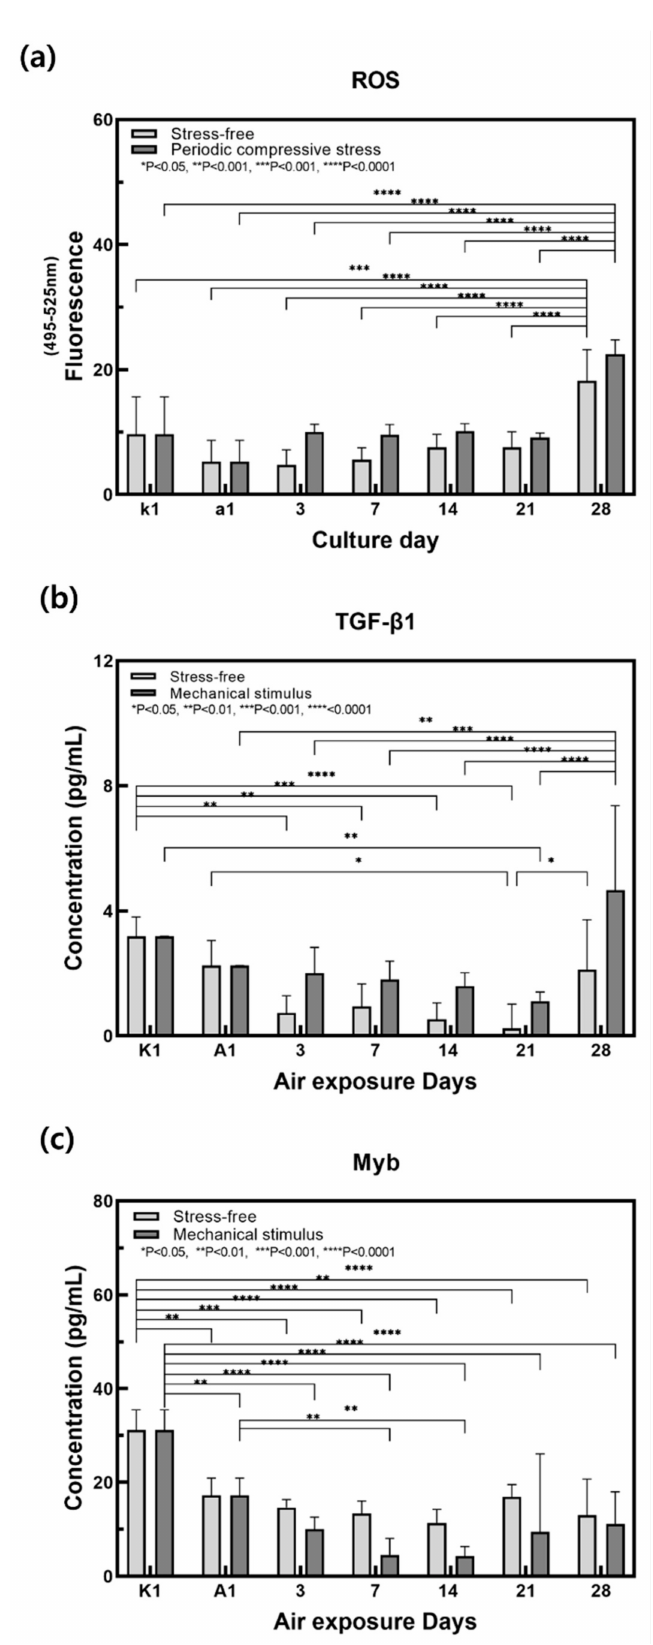
Figure 6. Variation of ( a ) ROS, ( b ) TGF- β 1, ( c ) Myb secretion for the samples without and with compressive stimulation for various air exposure days. ( n = 3; *, p < 0.05; **, p < 0.01; ***, p < 0.001; ****, p <